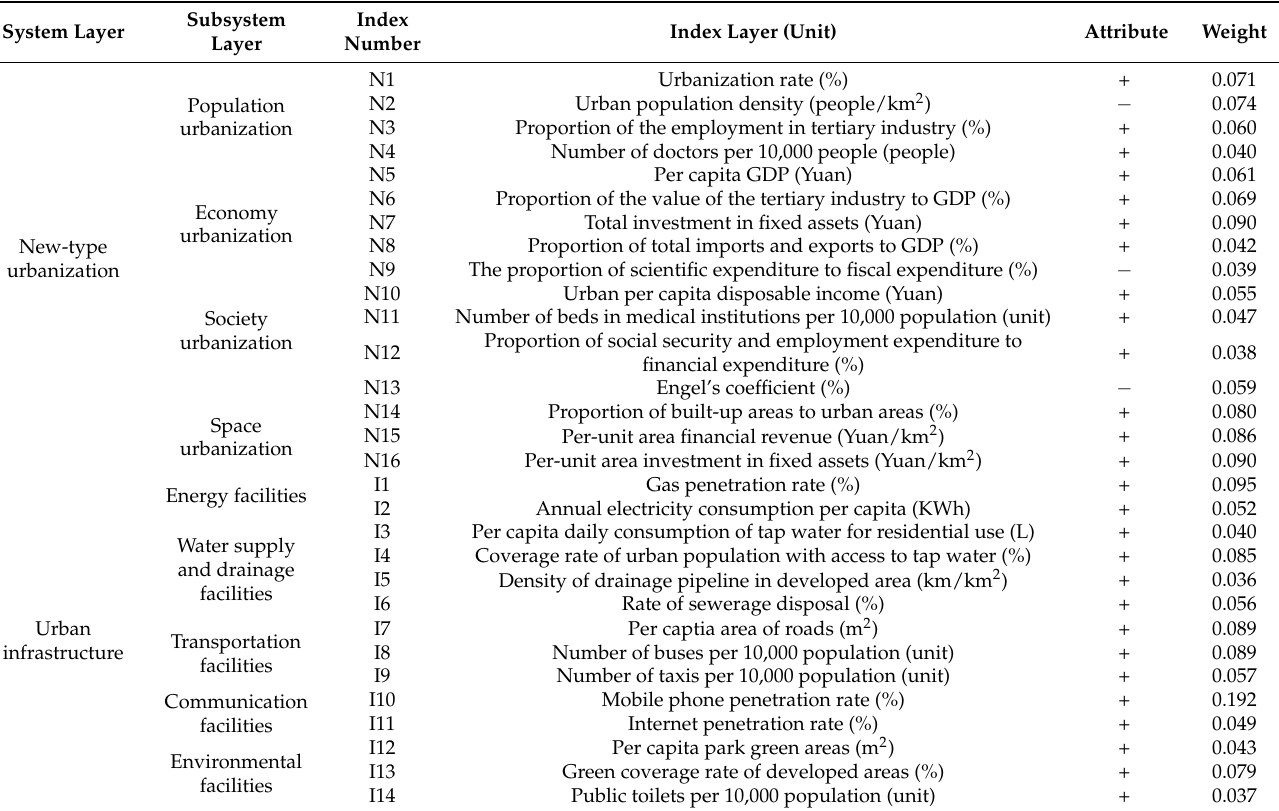
Table 1. New-type urbanization, urban infrastructure and urban environment index system and